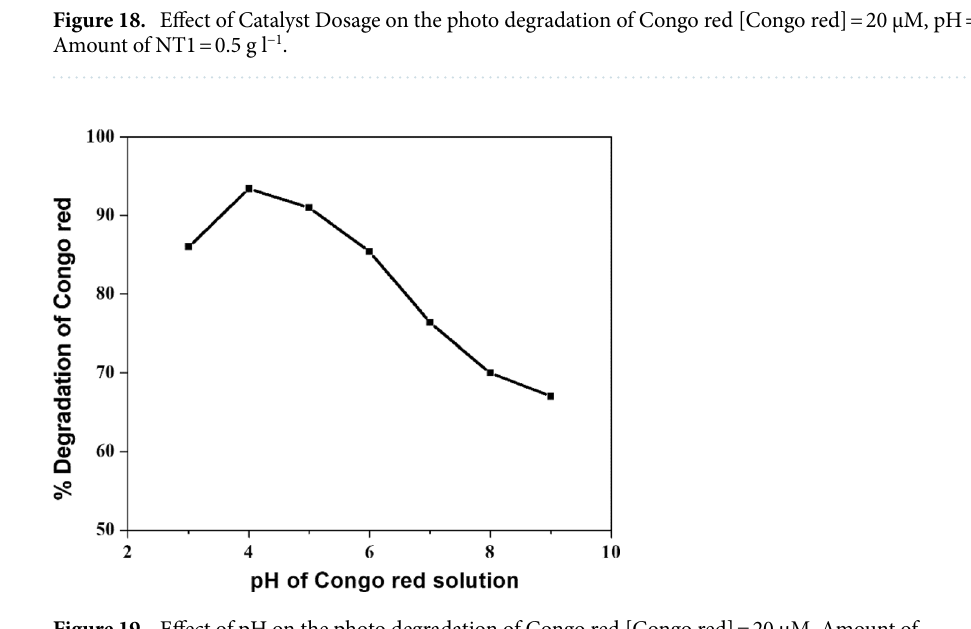
Figure 19. Effect of pH on the photo degradation of Congo red [Congo red] = 20 µM, Amount of NT1 = 0.5 g l −1